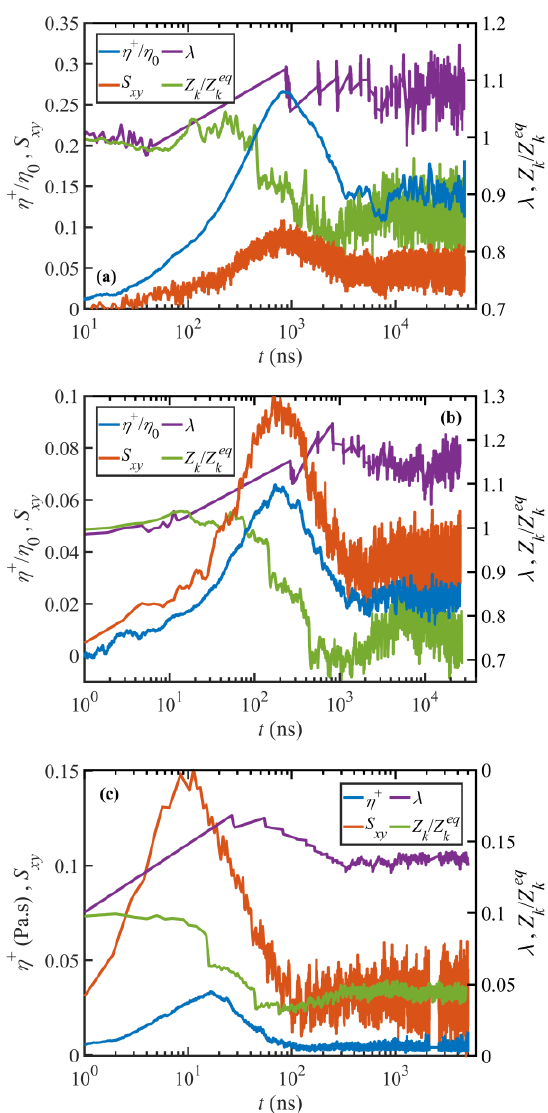
Figure 9. Shear viscosity (blue), the S xy component of the tube segmental orientation tensor (red), tube stretch λ (purple), and normalized entanglement density (green) versus time upon startup of shear flow at Wi = 12 ( a ), Wi = 58 ( b ), and Wi = 1170 ( c ). The dynamics of (cid:104) Z k (cid:105) are similar to those of λ except that the minimum in (cid:104) Z k (cid:105) corresponds to a maximum in λ . Note that in panel ( c ) there appear small gaps in some of the data profiles at long times where simulation data was accidentally